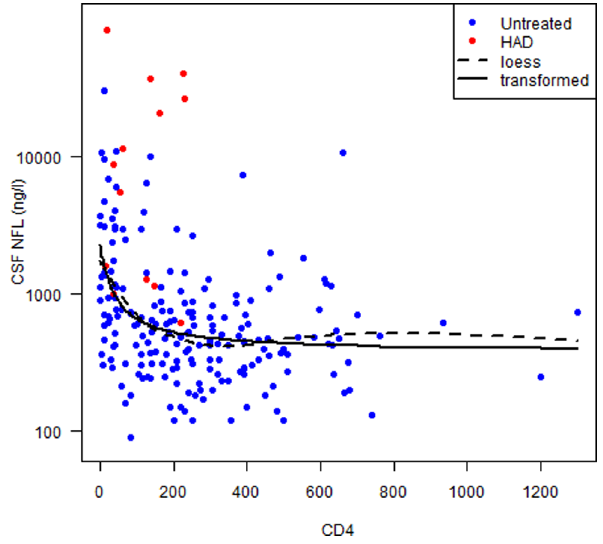
Figure 2. Correlations with CD4 T-cell counts and CSF NFL. A loess regression (dotted line) suggested an inverse transformation of CD4 + T-cell counts. Visual inspection reveals a rapid decline with increasing CD4 + T-cell counts that flattens out at around 250 cells/mL. The relationship between log 10 CSF NFL levels and CD4 + cell counts were fitted with non-linear regression using the function Log CSF NFL = b1 + b2/(CD4 + b3) (filled line). CSF NFL concentrations in patients with HIV-associated dementia (HAD) diagnosis, marked with red color in the figure were significantly elevated also compared to untreated neuroasymptomatic patients with equivalently low CD4 + T-cell counts, p , 0.001.